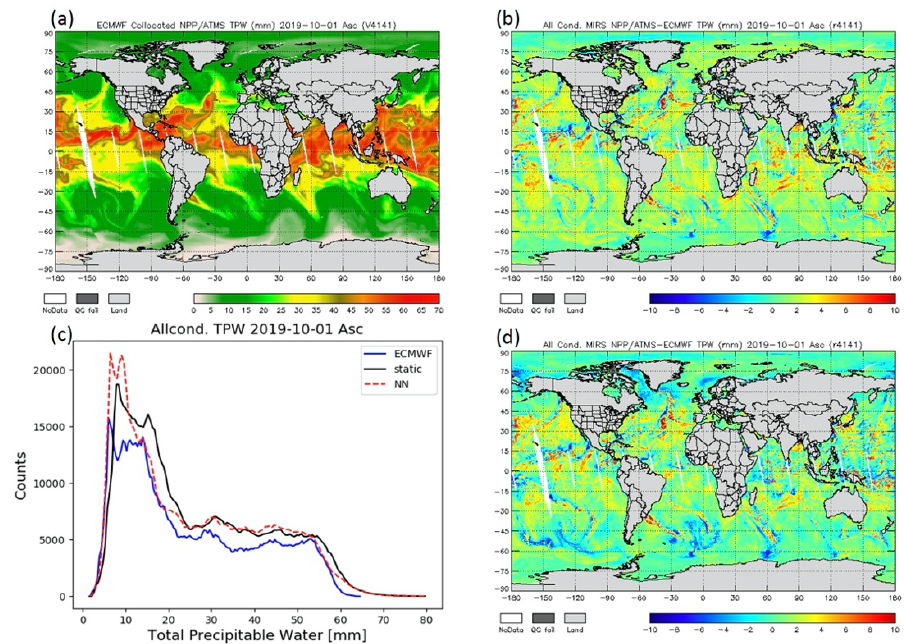
Figure 7. Total precipitable water (mm) of SNPP / ATMS on 1 October 2019, ascending node over ocean for ( a ) ECMWF analysis, ( b ) MiRS retrieval di ff erence with ECMWF using static bias correction, ( d ) MiRS retrieval di ff erence with ECMWF using NN bias correction, and ( c ) histograms of ECMWF and MiRS retrieval experiments shown in ( a ), ( b ), and ( d ).